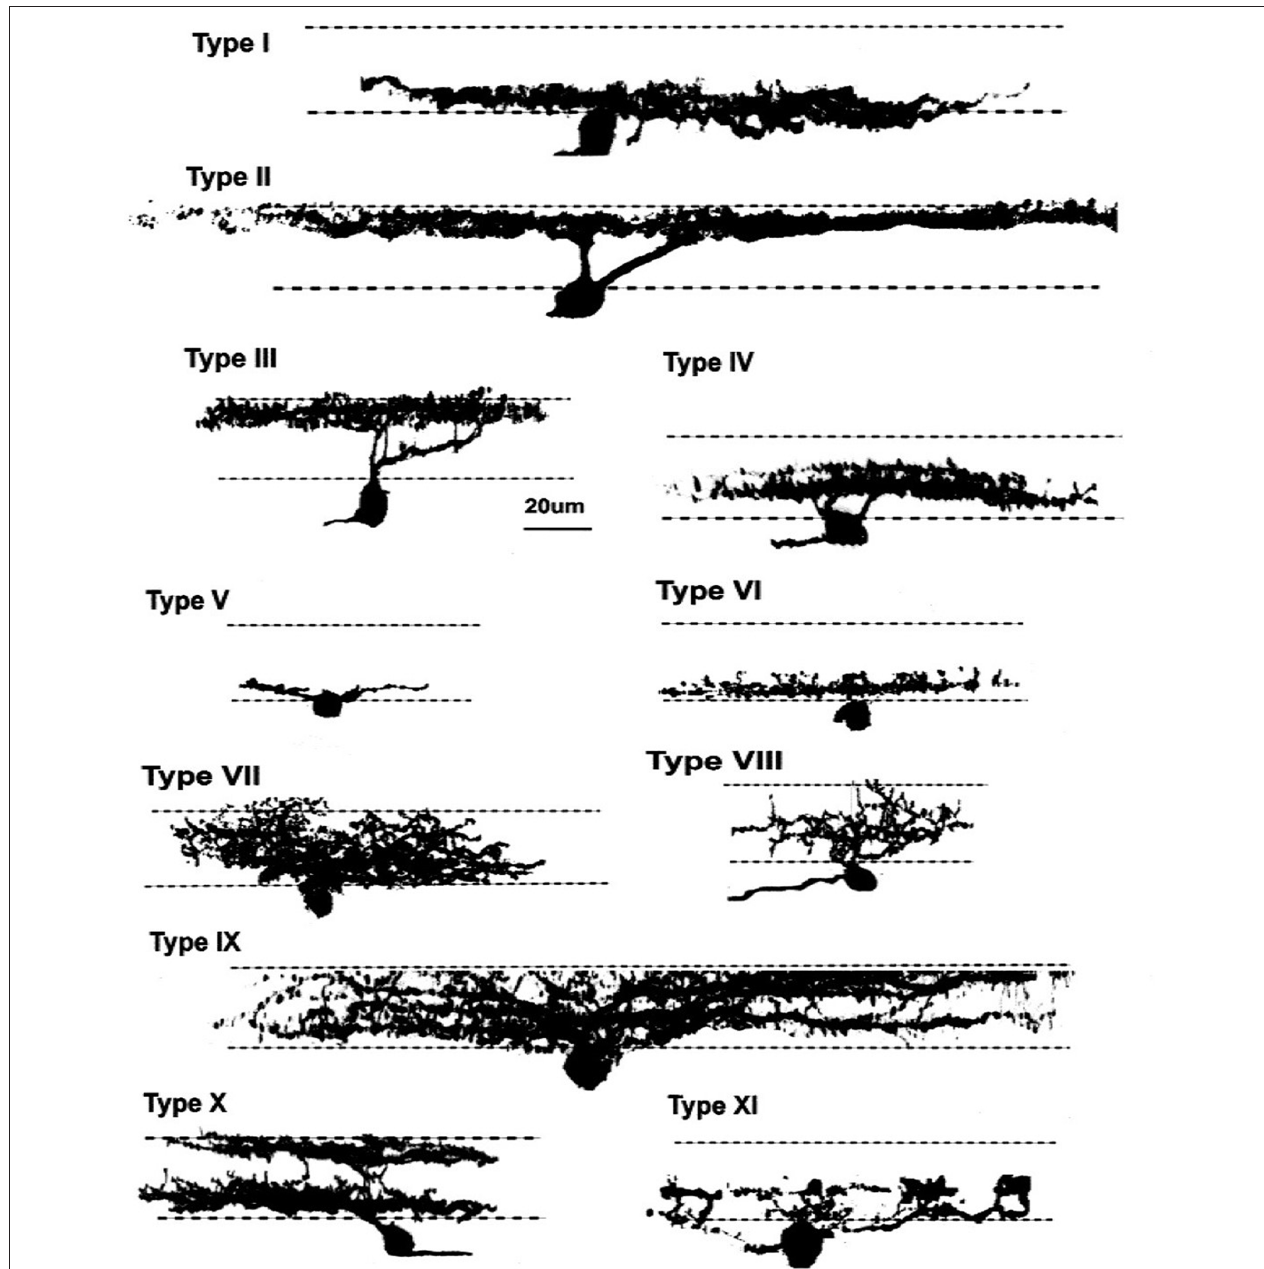
FIGURE 7 | Zebrafish ganglion cells (GCs). Di-I labeling of GCs in whole mount tissue identified 11 morphological types, based on dendritic arborization patterns in the IPL. These patterns included processes restricted to 1–2 sublaminae, as well as more diffuse arborization patterns. Reproduced with permission from Mangrum et al.